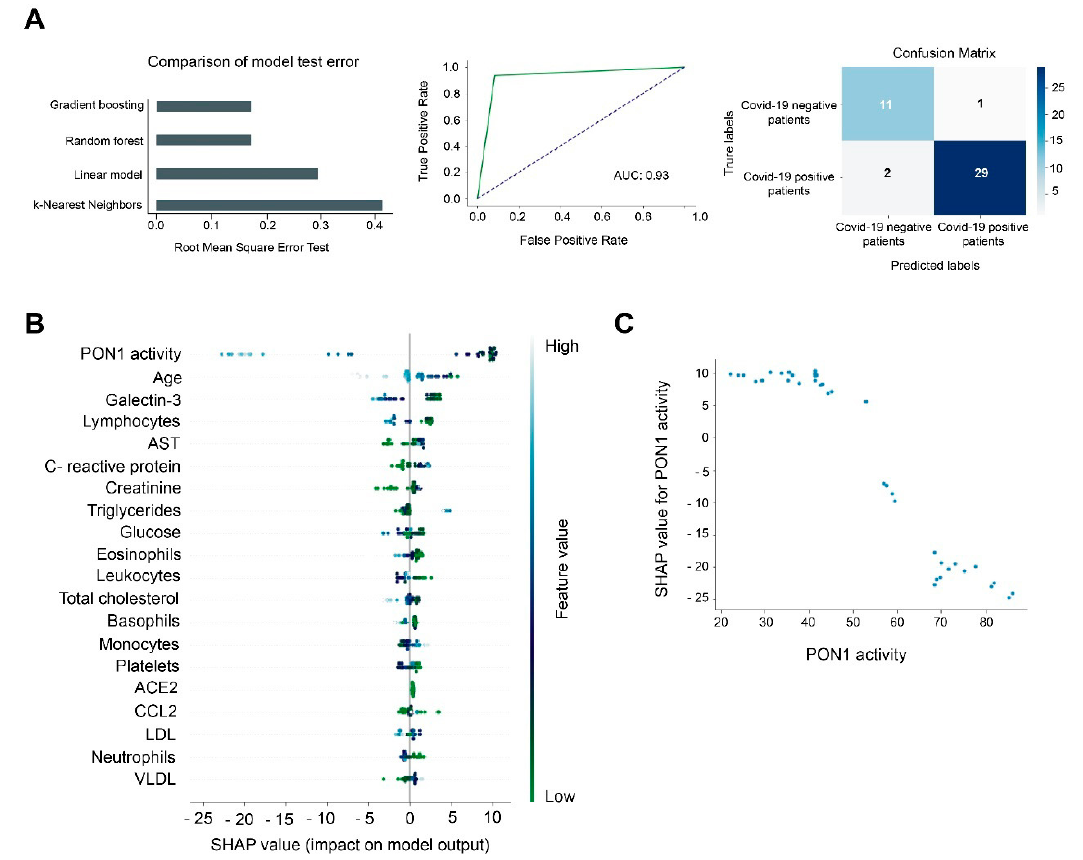
Figure 6. Gradient Boosting Machine (GBM) as a diagnostic model of prediction of COVID-19. PON1 activity discriminates between COVID-19 positive and negative patients. ( A ) Root mean squared error test of the GBM, Random Forest, Lineal Model, and K-Nearest Neighbors. The Receiver Operating Characteristic curve and matrix confusion of the GBM model shows an area under the curve (AUC) of 0.93. ( B ) SHapley Additive exPlanations (SHAP) summary plot of the GBM model showing the top 20 features predicting COVID-19. Positive SHAP values indicate the presence of COVID-19 in patients, while negative values indicate the absence of disease. The colors indicate high (light blue) or low (light green) levels of each of the variables. SHAP values on the x -axis indicate the distribution of the prediction among the features. ( C ) Partial Dependence plot of PON1 activity.